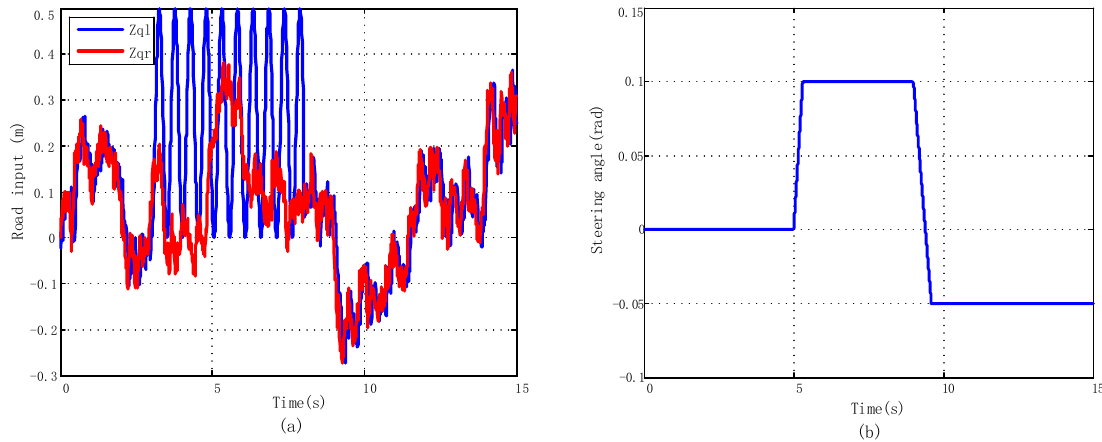
Figure 24. The input signals of vehicle: ( a ) the bump road; ( b ) the steering angle under the fishhook maneuver.